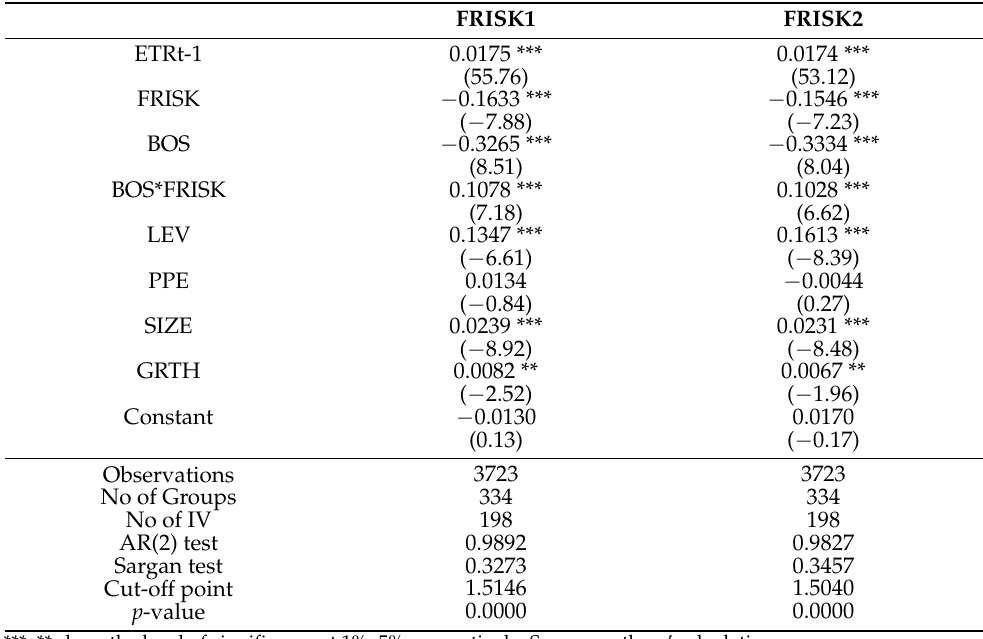
Table 10. The effect of Board Supervisors on the relationship between firm risk and the level of tax